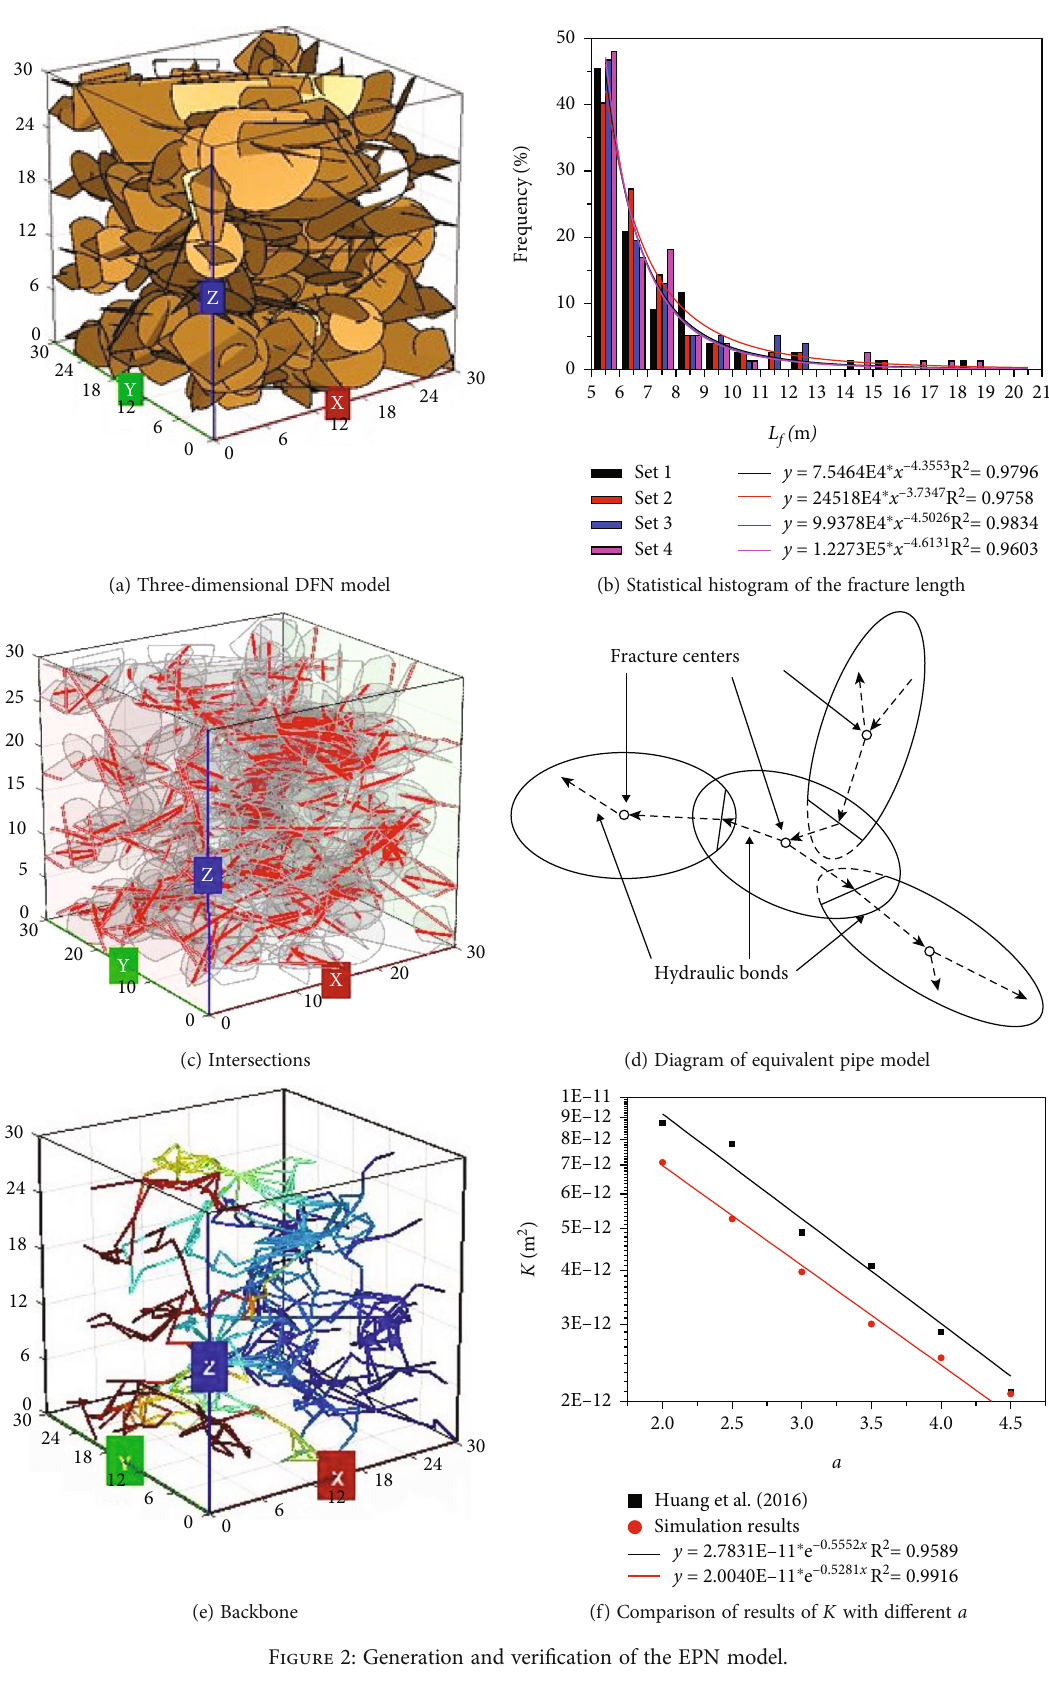
Figure 2: Generation and veri fi cation of the EPN